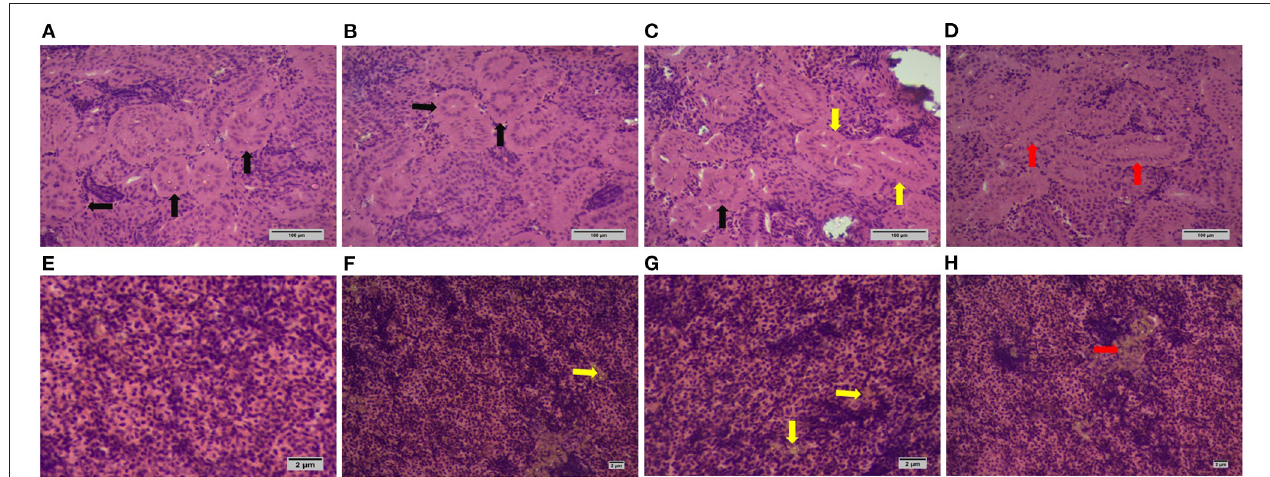
FIGURE 1 | Histoarchitecture of kidney and liver of experimental Oreochromis niloticus (H & E; X100 magnification; scale bar: 100 µ m for kidney and 1 µ m for liver samples). The normal glomerular structure is indicated by black arrows observed in control (A) and T1 (B) ; both normal (black arrow) and slight widened (yellow arrow) structures are found in T2 (C) ; extremely widened glomerulus is indicated by red arrows observed in T3 (D) . (E) indicates normal liver histology from control fish with no fat deposition; liver sections from T1 (F) and T2 (G) showed a slight fat deposition (yellow arrows), while T3 (H) experienced a higher deposition (red arrow).